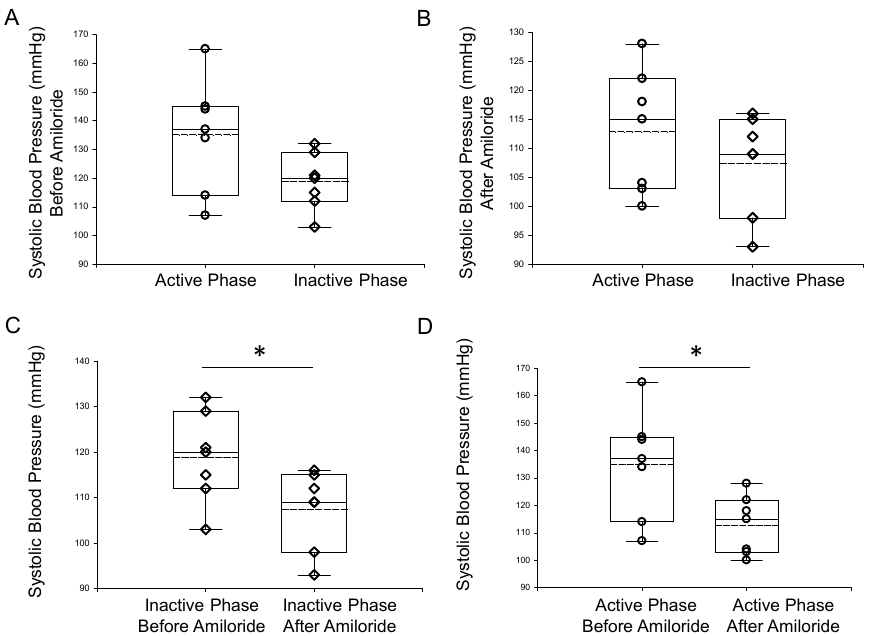
Figure 1. Tail cuff systolic blood pressure measurements of 18-month-old male mice during the in- active (AM) phase (IP) and active (PM) phase (AP). ( A ) Summary plot of systolic blood pressure in aged male mice taken during the inactive phase (8 AM) or during the active phase (8 PM). ( B ) Sum- mary plot of systolic blood pressure in these mice at the same time points but after the mice were injected with benzyl amiloride. ( C ) Summary plot of systolic blood pressure during the inactive phase (8 AM) before and after the mice were injected with benzyl amiloride. ( D ) Summary plot of systolic blood pressure during the active phase (8 PM) before and after the mice were injected with benzyl amiloride. A Wilcoxon rank sum test was performed to compare the two groups. n = 7 mice in each group. The open circles represent individual data points from the AP group and the open triangles represent individual data points from the IP group. * Represents a p -value of ≤ 0.05.